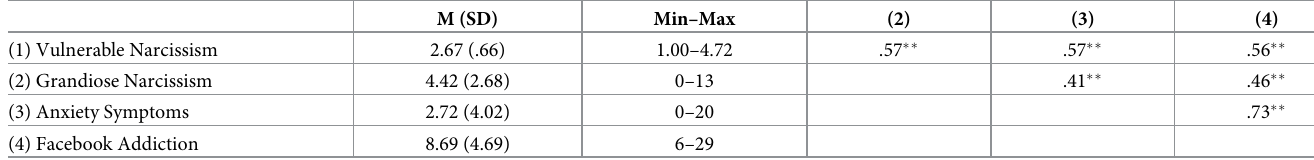
Table 1. Descriptive statistics and correlations of vulnerable and grandiose narcissism, anxiety symptoms and Facebook